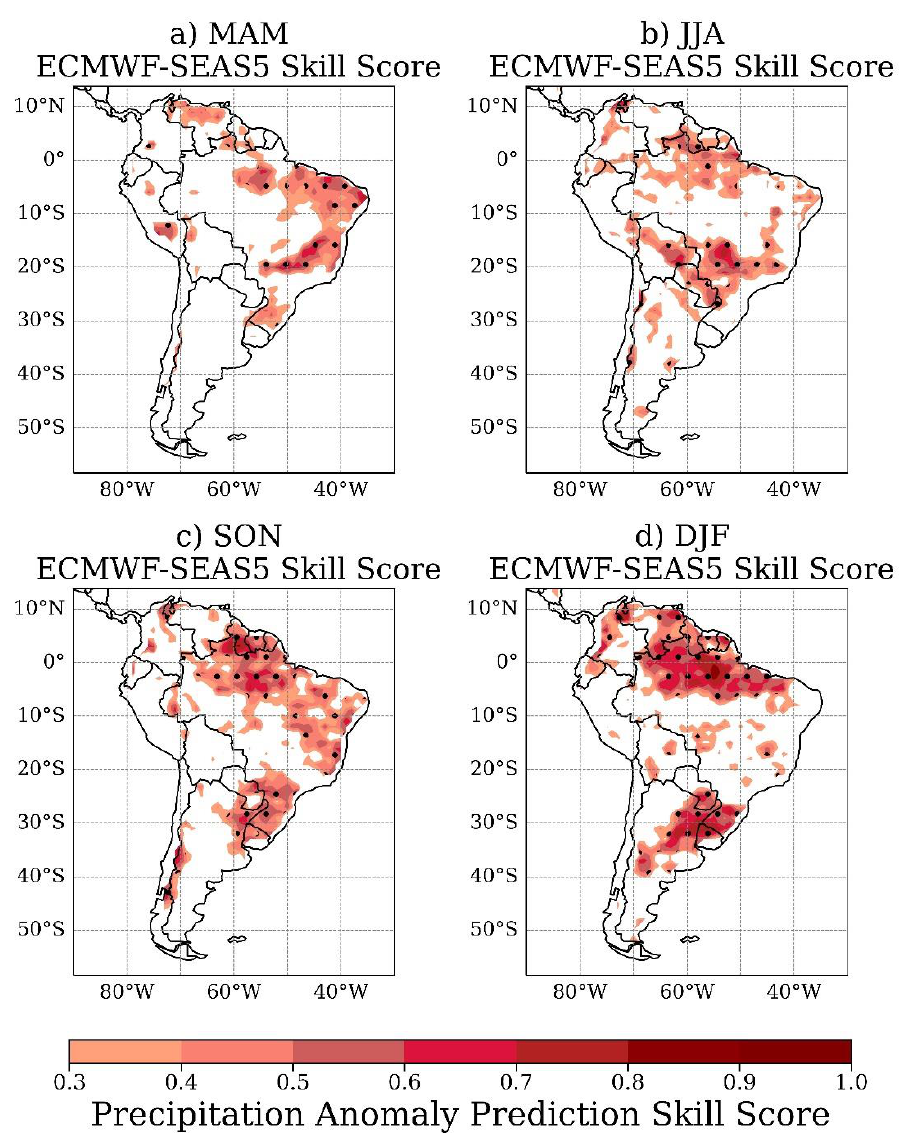
Figure 7. Seasonal precipitation anomaly prediction skill scores greater than 0.3 for the ECMWF- SEAS5 hindcasts for ( a ) MAM, ( b ) JJA, ( c ) SON, and ( d ) DJF. Seasons correspond to reforecasts from the 1–3-month lead times. The score is nondimensional. Dotted areas denote statistical significance at a 95% confidence level using the Student’s t -test.